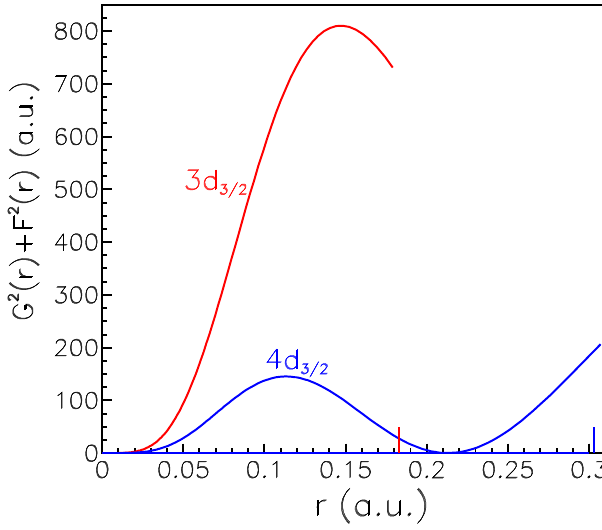
] for the 3 d (red) and 0 3 / 2 for the 3 d (red) and 0 3 / 2 − 1) × 100% for RR of W 28+ with an n